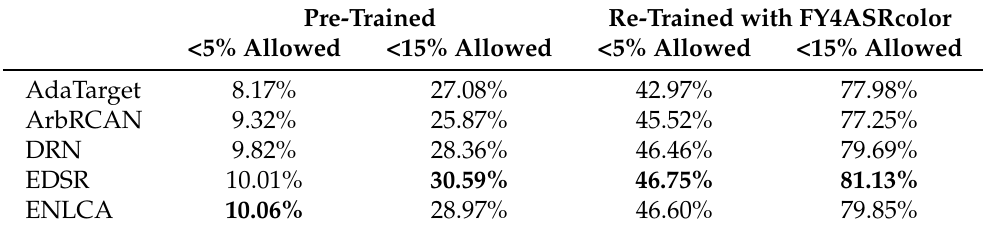
Table 7. Correctness ratio on FY4ASRcolor